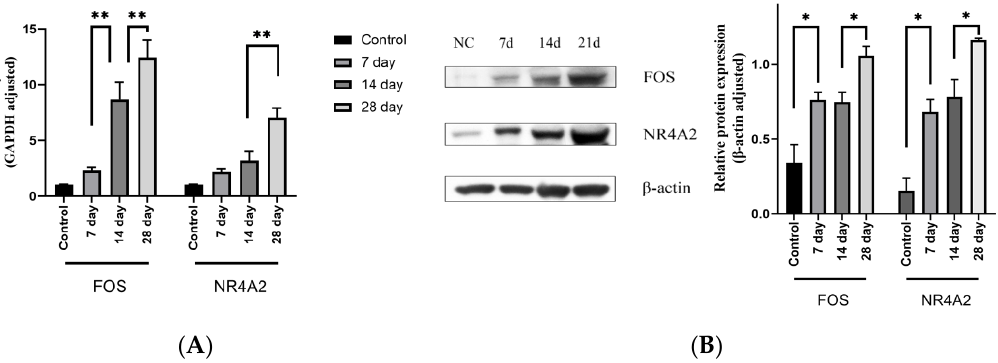
Figure 8. ( A ) mRNA expression level of FOS and NR4A2 in rat samples. The expression level of mRNA gradually increased with the extension of time after surgery. ( B ) Protein expression level of FOS and NR4A2 . Similar to the results for the mRNA, protein level gradually increased with the extension of time after surgery. Data analysis was performed using one-way ANOVA test. * p < 0.05 and ** p < 0.01.